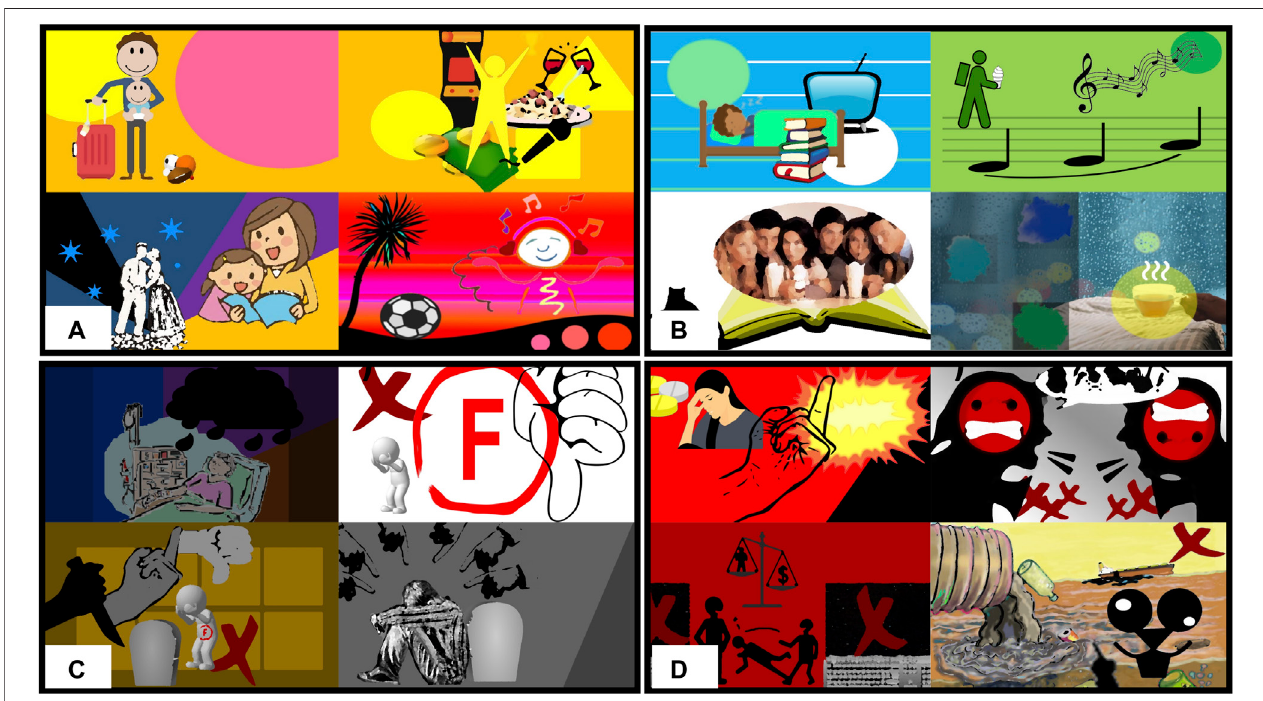
FIGURE 6 | Personalized sketches for four participants: (A) happy, (B) relaxed, (C) sad, (D) angry.